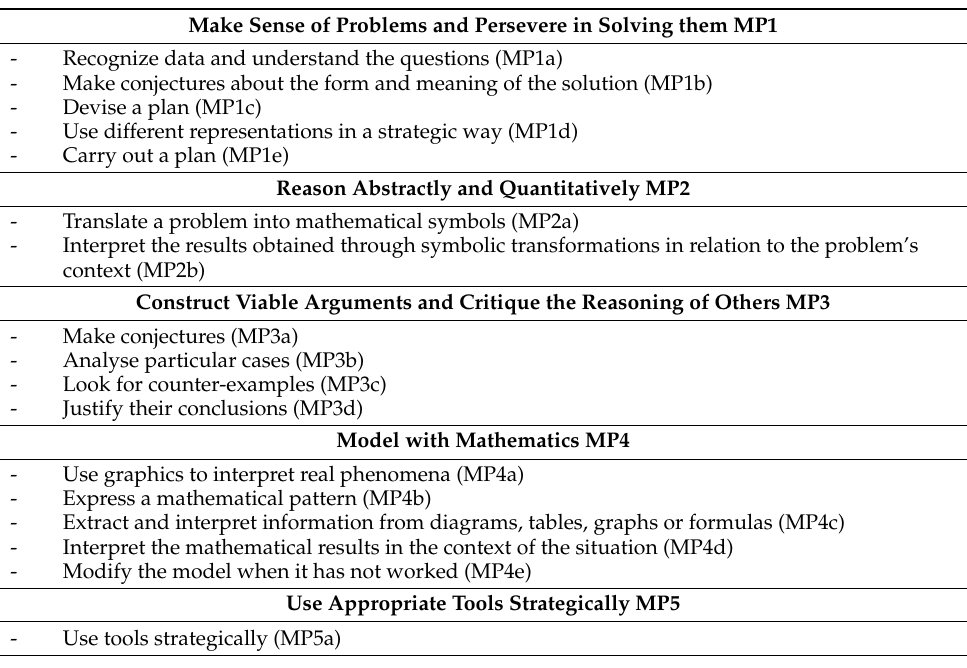
Table 2. Indicators for the analysis of mathematical practices adapted from NGACBP [14].